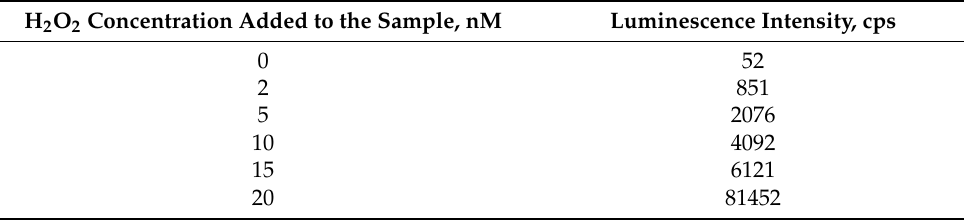
Table 1. Calibration data used to determine the concentration of hydrogen peroxide in aqueous solutions (data from one of the experiments).